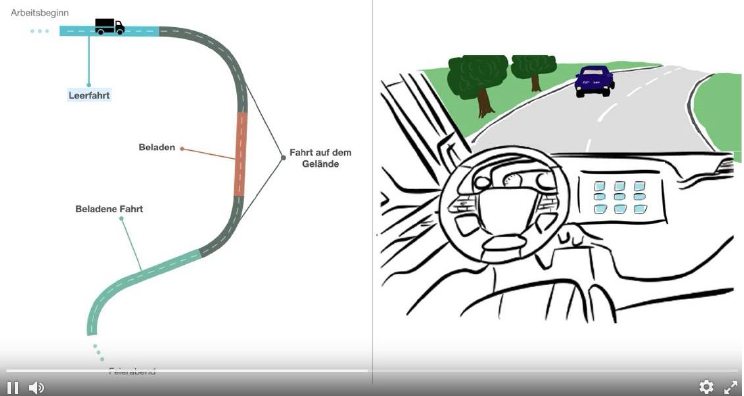
Figure 6. Screenshot of the video shown to the participants explaining the basic functionality of an AUI for commercial vehicles. The left section shows the current working phase on a timeline which leads to different vehicle functions shown in the schematic driving workplace on the right.